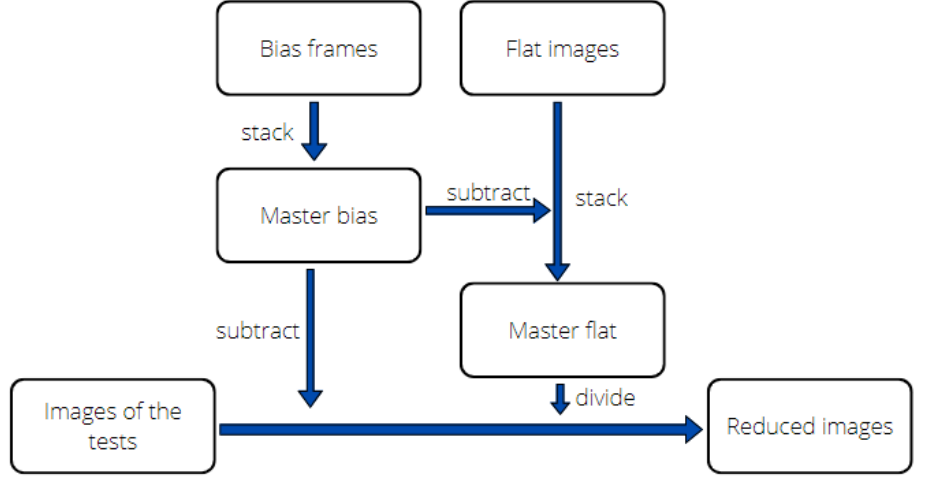
Figure 9. Some detected objects.